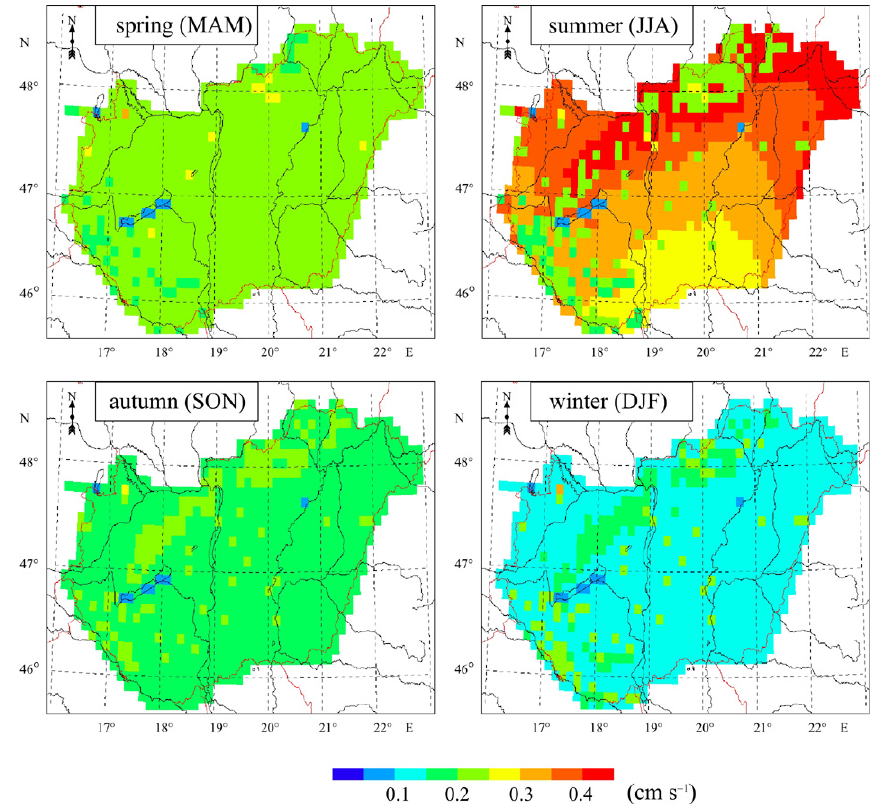
Figure 3. Average daily dry deposition velocity of ozone for di ff erent seasons in the control period (1961–1990) over Hungary.